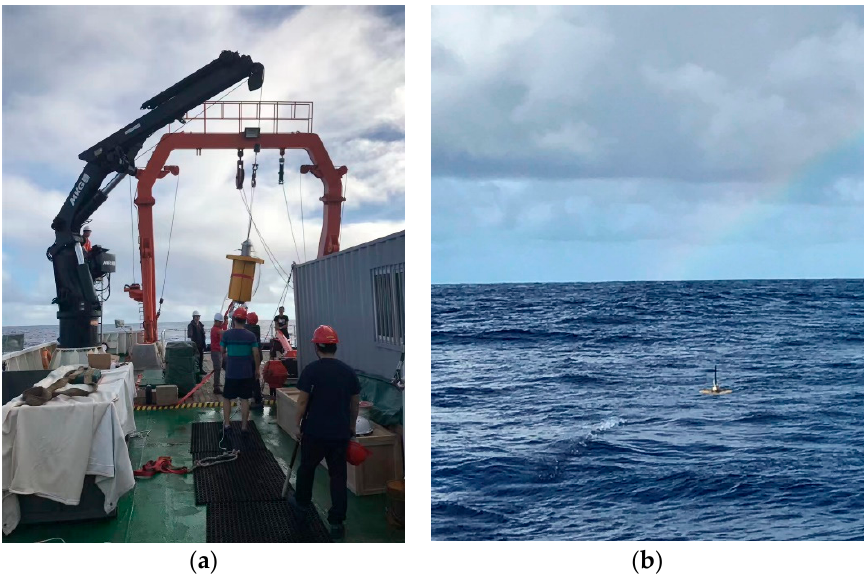
Figure 1. ( a ) The lifting process; ( b ) the deployment of our profiling float.